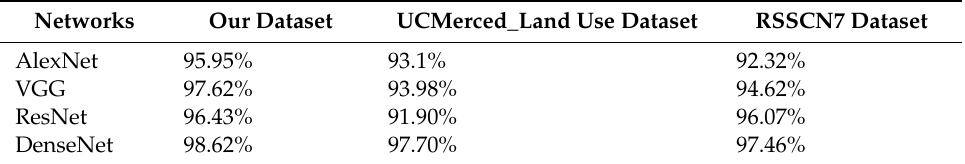
Table 8. Comparing with two datasets using four classic